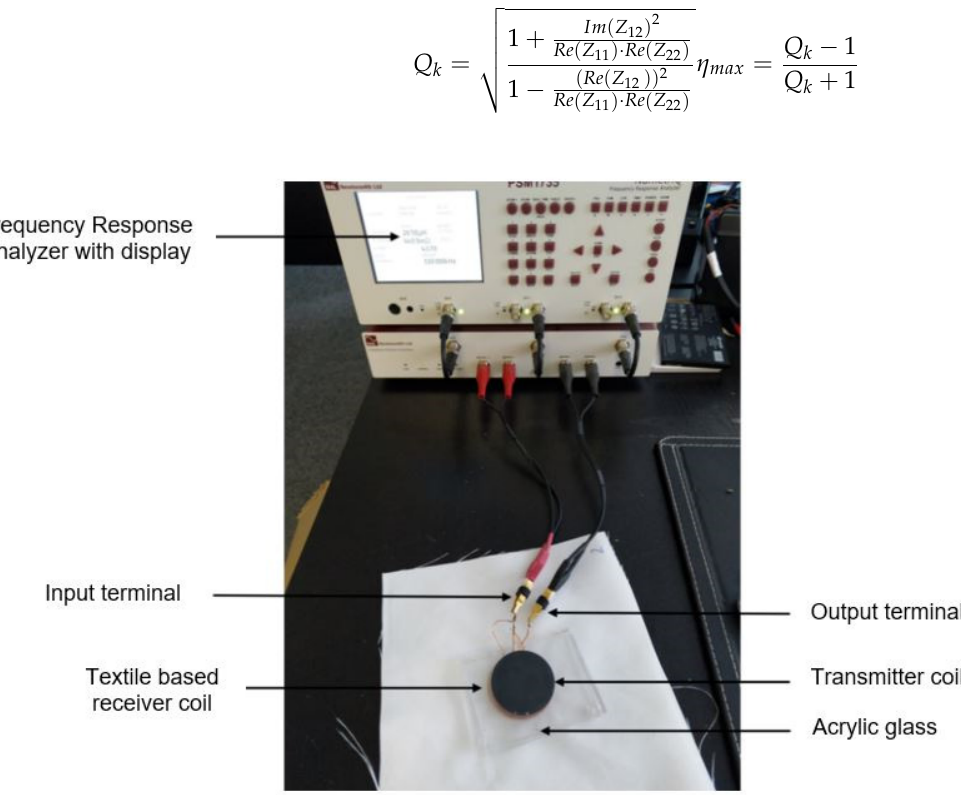
Figure 13. Picture of the test setup.